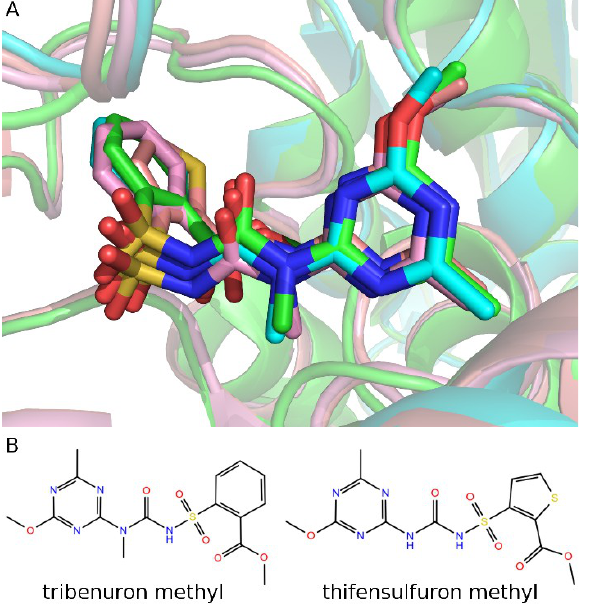
Fig 3. Comparison of the two sulfonylurea herbicides binding to At AHAS, Sc AHAS, and Ks AHAS (A) and chemical structures of tribenuron methyl and thifensulfuron methyl (B). At AHAS and Ks AHAS are superposed onto Sc AHAS. Carbons in At AHAS-tribenuron methyl (1YI1), Sc AHAS-tribenuron methyl (1T9A), Ks AHAS- tribenuron methyl, and Ks AHAS-thifensulfuron methyl complexes are colored cyan, green, pink, and salmon,